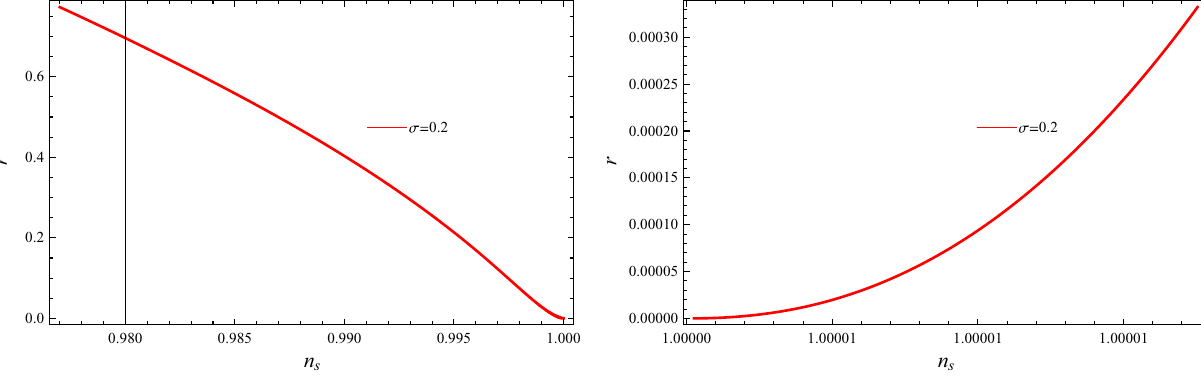
weak dissipative regime are r ≤ 0 . 38, 0 . 000041, 4 . 5 × + 0 . 0001 . 0031 + 0 . 0001 10 − 6 according to n s = 1 . 0000 − 0 . 0001 , 1 − 0 . 0001 , + 0 . 0001 1 . 0040 − 0 . 0001 , respectively, and for the strong dissipa- tive regime r ≤ 0 . 0055, 4 . 0 × 10 − 28 , 5 . 2 × 10 − 44 for n s = + 0 . 0001 . 000057 + 0 . 000001 . 00002 + 0 . 00001 1 . 0004 − 0 . 0001 , 1 − 0 . 000001 , 1 − 0 . 00001 ,